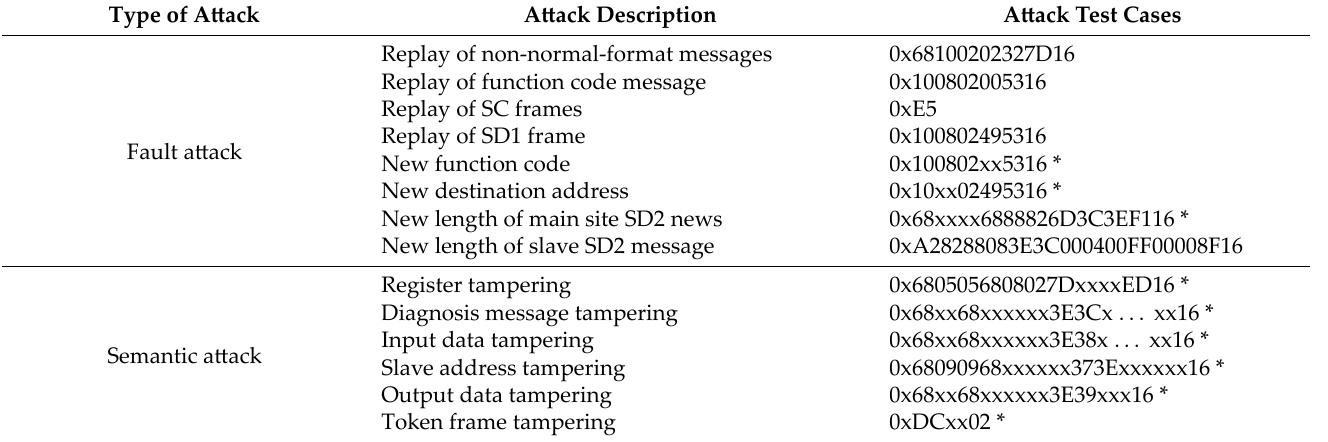
Table 1. Attack model